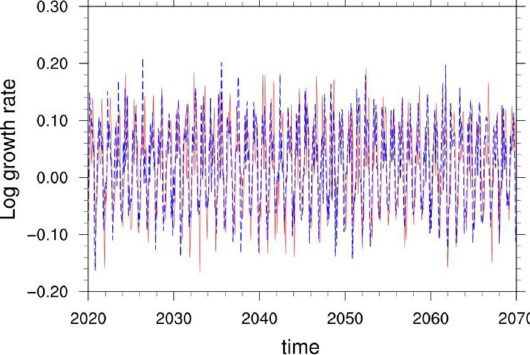
Projected change of maximal and minimal coral growth ratio under aerosol geoengineering implementation when compared with the